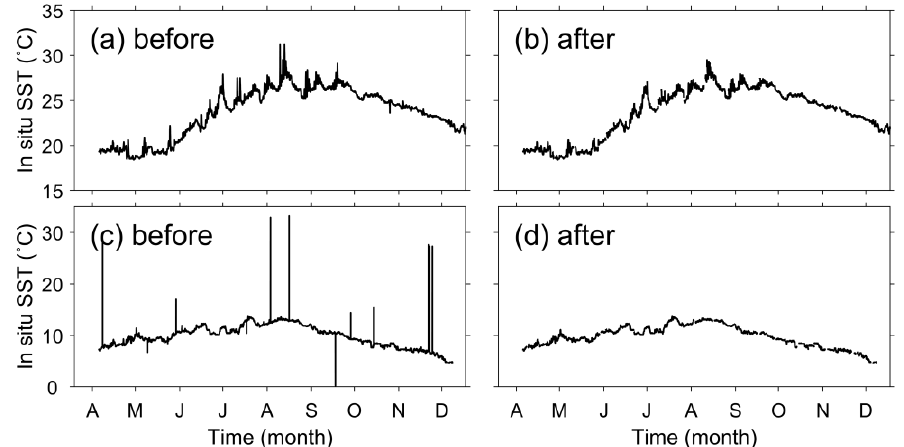
Figure 2. An example of time series of in-situ drifter temperatures (°C) ( a ) before and ( b ) after QC procedure to eliminate abnormal temperatures in 2011. ( c , d ) present another example of the QC procedure.